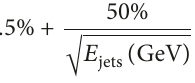
relevant backgrounds at the first energy stage of CLIC. The 𝑒 + 𝑒 − → ]] 𝐻 signal process includes both s-channel 𝑒 + 𝑒 − →